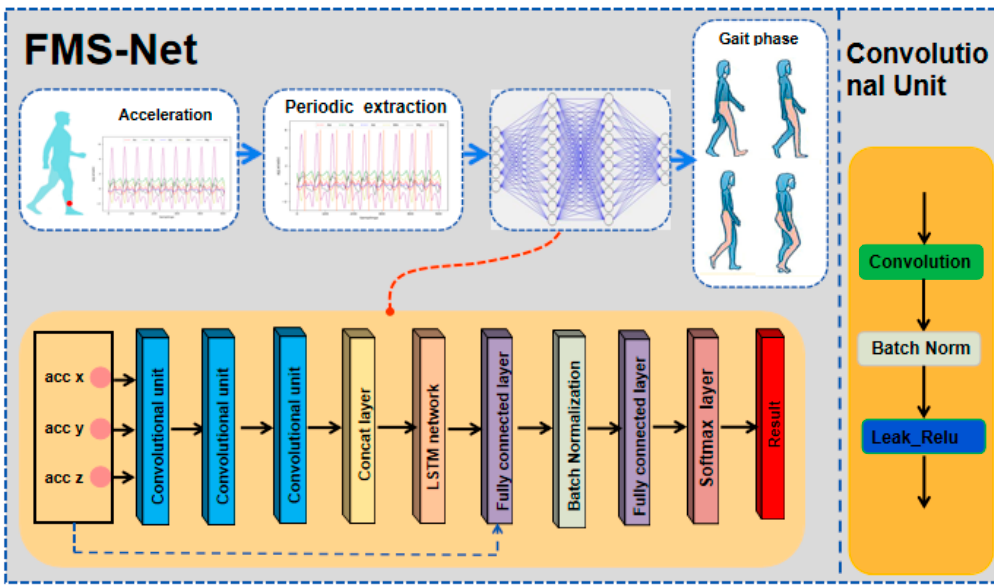
Figure 6. Proposed network (FMS-Net) architecture.